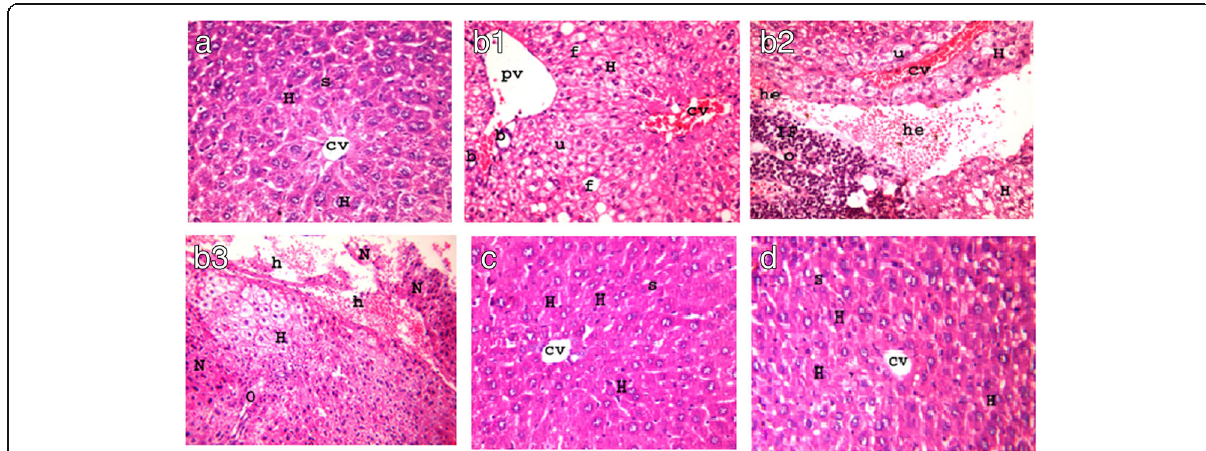
Fig. 2 A photomicrograph of liver sections. a Control group showing normal hepatic architectures with polygonal hepatocyte (H), normal central vein (CV), and sinusoid (S). b1 Mice treated with cadmium only showing scattered areas of fatty change (f) in most hepatocyte and diffused extensive congested central vein (CV) with dilated congested portal vein (pv), and proliferated bile duct (b). b2 Mice treated with cadmium only showing severe dilated congested central vein (cv), few enucleated hepatocyte (u), scattered dense aggregation of inflammatory cells (IF), and hemorrhage (he). Hepatocyte with pyknotic nucleus and severe vacuolated cytoplasm (H) together with edema (o) were also seen. b3 Mice treated with cadmium only showing scattered necrotic areas (N), severe dilated congested central vein (cv), and hemorrhage (h). Hepatocyte with pyknotic nucleus and severe vacuolated cytoplasm (H) together with edema (o) were also seen. c Mice treated with nano-chocolate fortified with zinc only showing hepatocyte with vesicular nucleolus (H) and normal appearance of both central vein (CV) and sinusoid (s). d Mice treated with cadmium and nano-chocolate fortified with zinc showing normal histological structure : normal shape of hepatocyte (H) radiated in columns from central vein (CV) and separated by sinusoid (s) (H & E X 200)